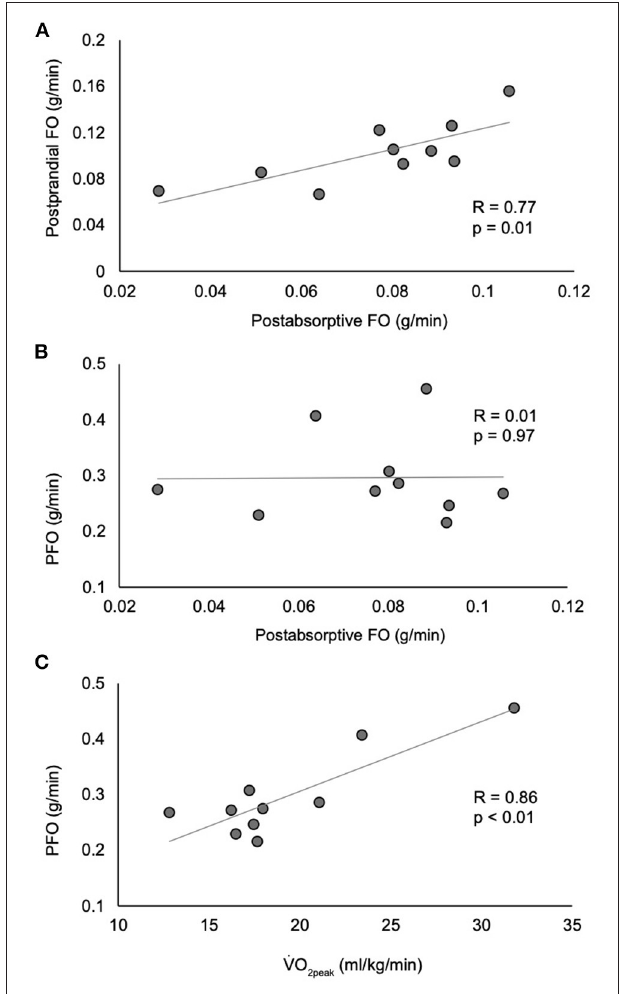
FIGURE 3 | Correlations between postabsorptive fat oxidation and postprandial fat oxidation (A) , peak fat oxidation (B) , and between VO 2peak and peak fat oxidation (C) . n = 10. FO, fat oxidation; PFO, peak fat oxidation; VO 2peak , peak oxygen